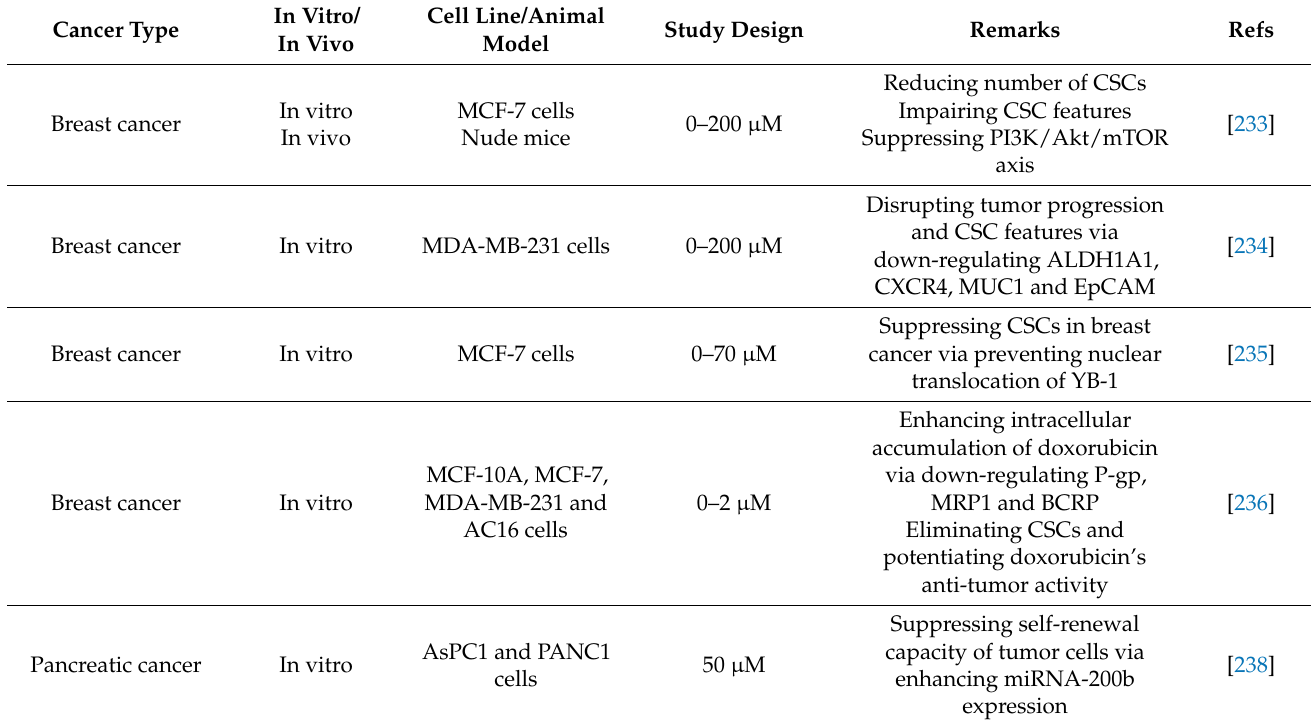
Figure 3. The potential of bioactive constituents of pomegranate in suppressing CSCs. Table 4. The CSCs as promising targets of quercetin in tumor